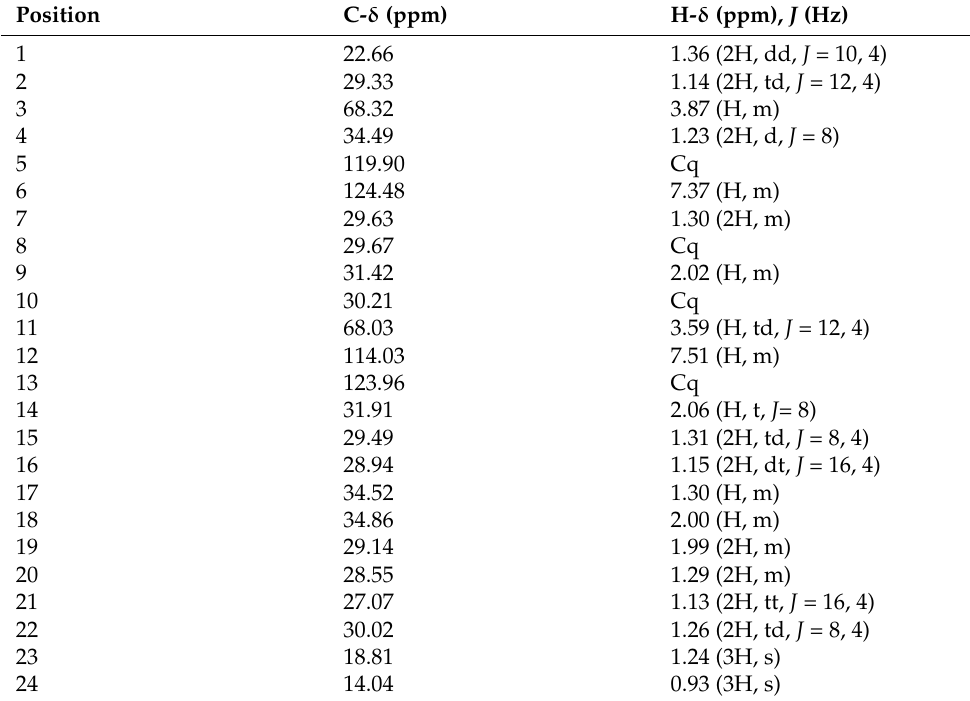
Table 3. The carbon-12 and proton (H-1) signals for